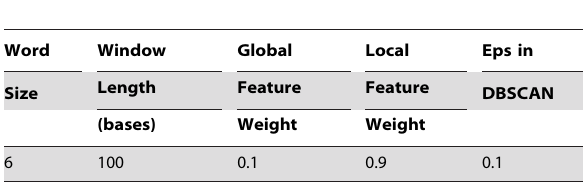
Table 3. The parameters values used by the hbd_EST in comparative study.